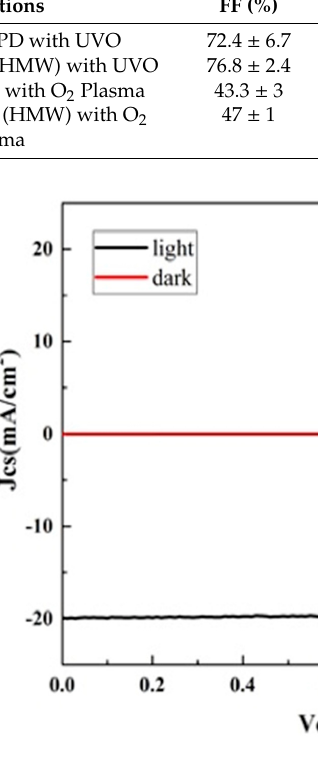
Figure 9. Current–voltage characteristics of champion devices based on perovskite/starch film deposited on the treated Poly-TPD (HMW) layer by UV-Ozone (UVO).